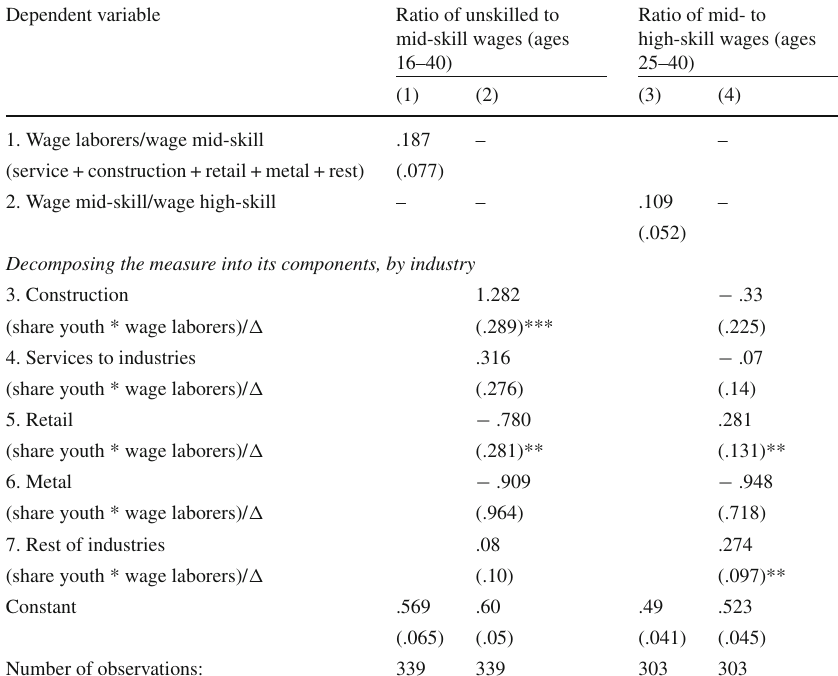
Table 4 Actual wages and wages in collective